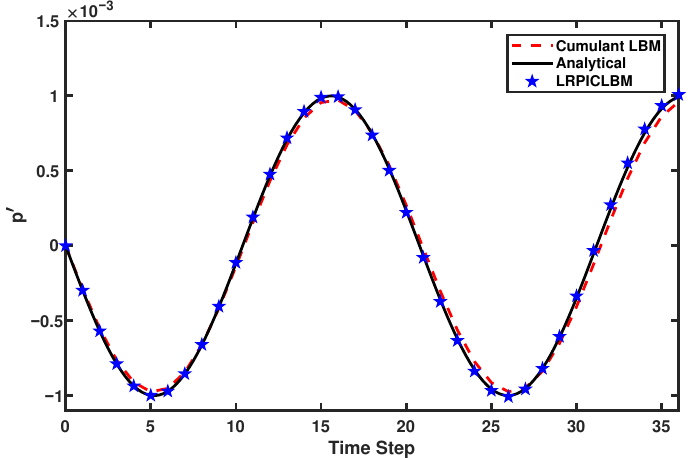
∆ x 2 ∆ t ) with N ppw = 12